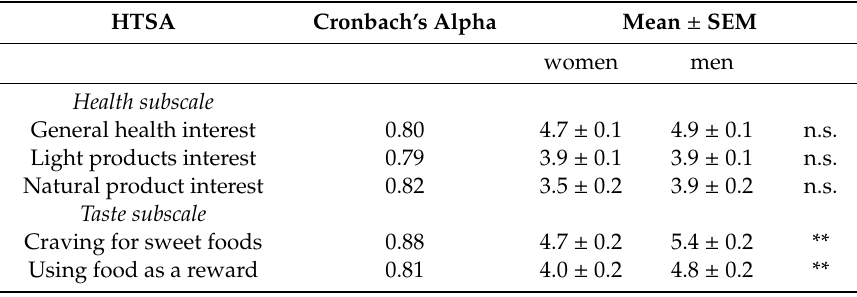
Table 5. HTSA subscales means by gender and Cronbach’s alpha